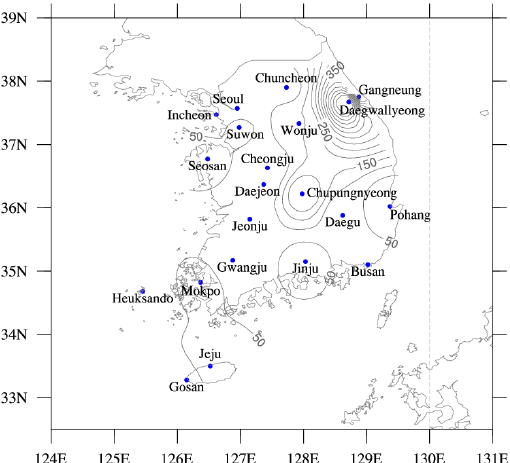
Figure 1. Spatial distribution of the global solar radiation network in Korea. An isoline contour at 50-m intervals represents the elevation.